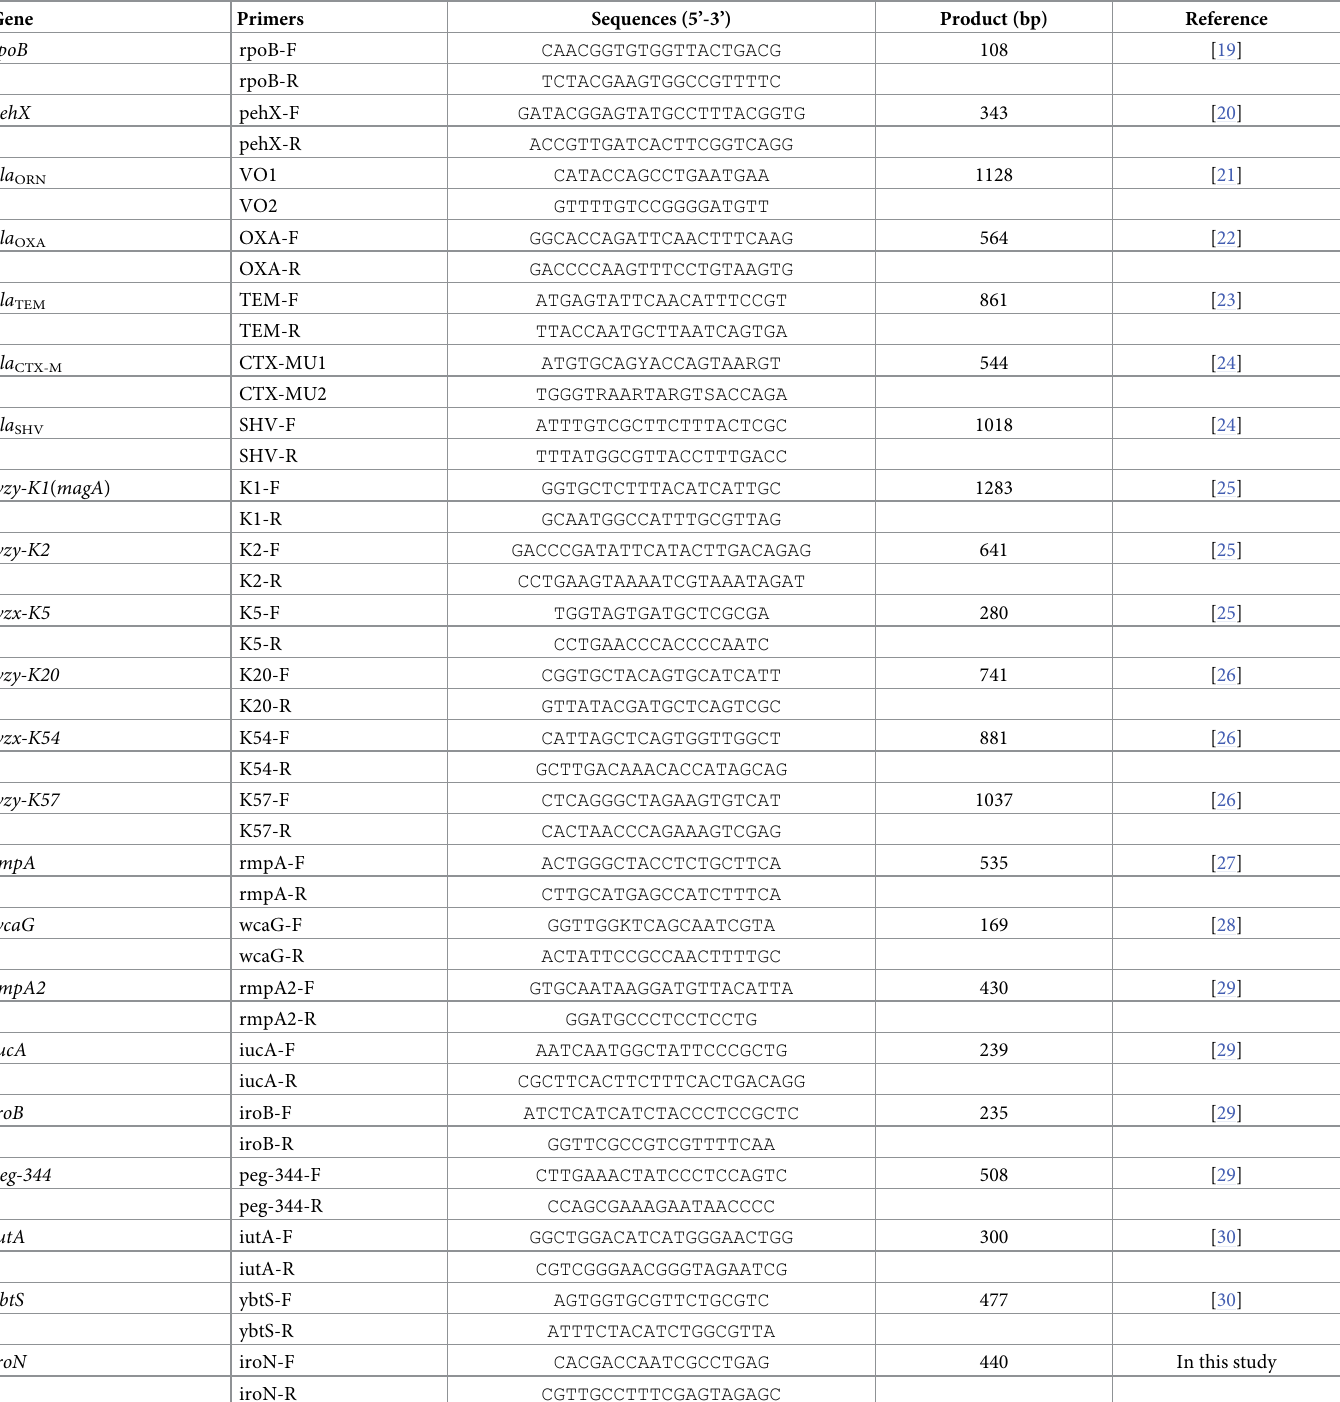
Table 1. Primers used in the